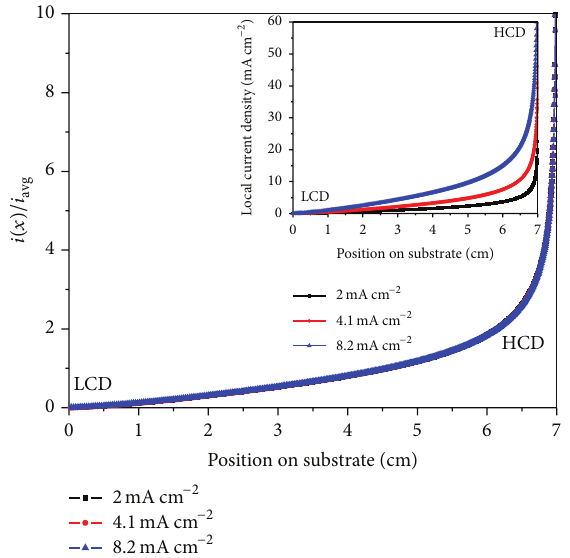
Figure7: Primarycurrentdistributionformodified Hull cell during Cu electrodeposition carried out at different applied average current densities of 2, 4.1, and 8.2 mAcm −2 .